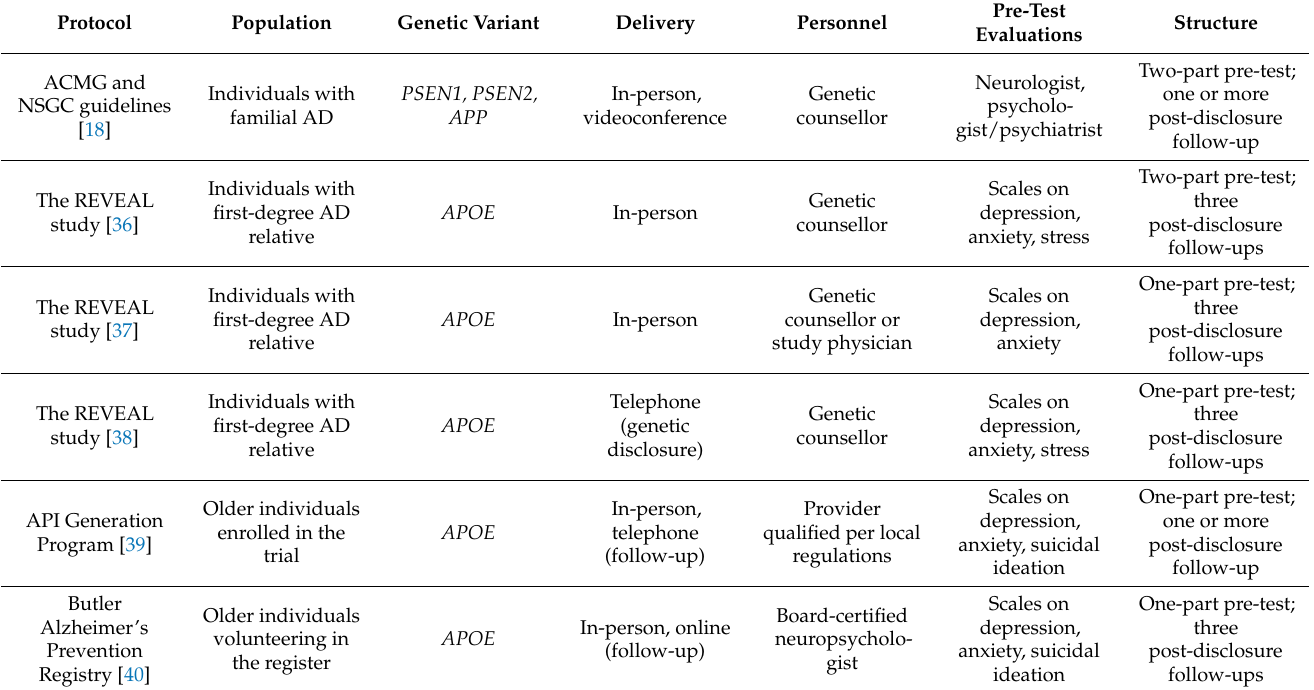
Table 1. Clinical guidelines and research protocols for AD genetic risk